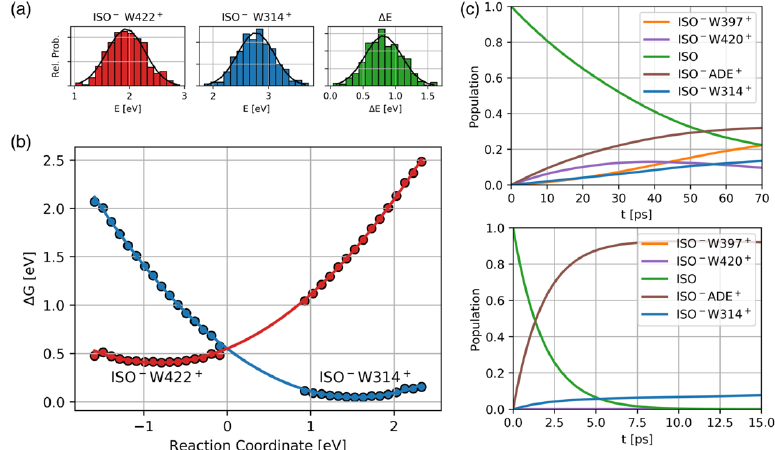
Fig. 2. (a) Representative energy histogram of ISO − W422 + and ISO − W314 + charge separated states and respective energy difference distribution employed for calculation of free energy surfaces shown in (b) [5]; presented data in (a) for a trajectory evolving in the ISO − W422 + state. (c) Population dynamics of wild-type dCRY (top) and in silico mutated dCRY (bottom), evaluated with the MGACIC-QUAPI method [6] (top: 2048 time steps memory interval = 130.3 fs, 64 effective mask elements; bottom: 128 time steps memory interval, 32 effective mask